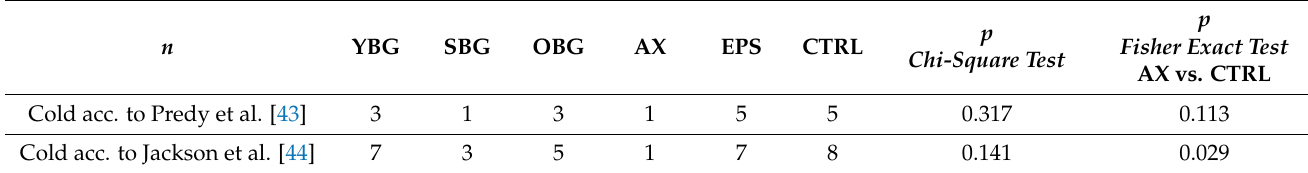
Table 6. Number of subjects with common cold episodes during the intervention period (V1–V4).